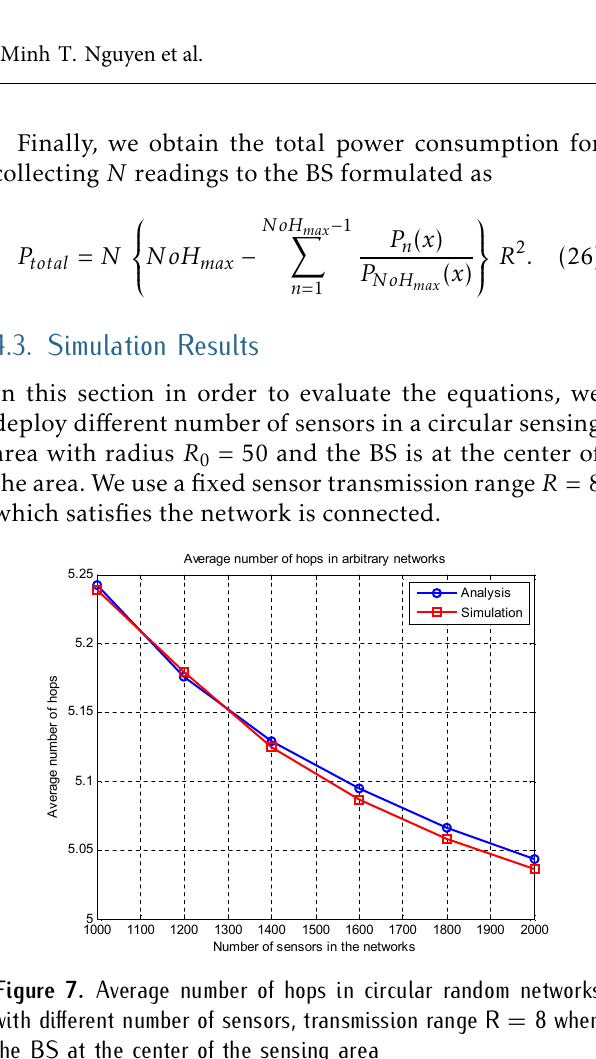
Figure 7. Average number of hops in circular random networks with different number of sensors, transmission range R = 8 when the BS at the center of the sensing area